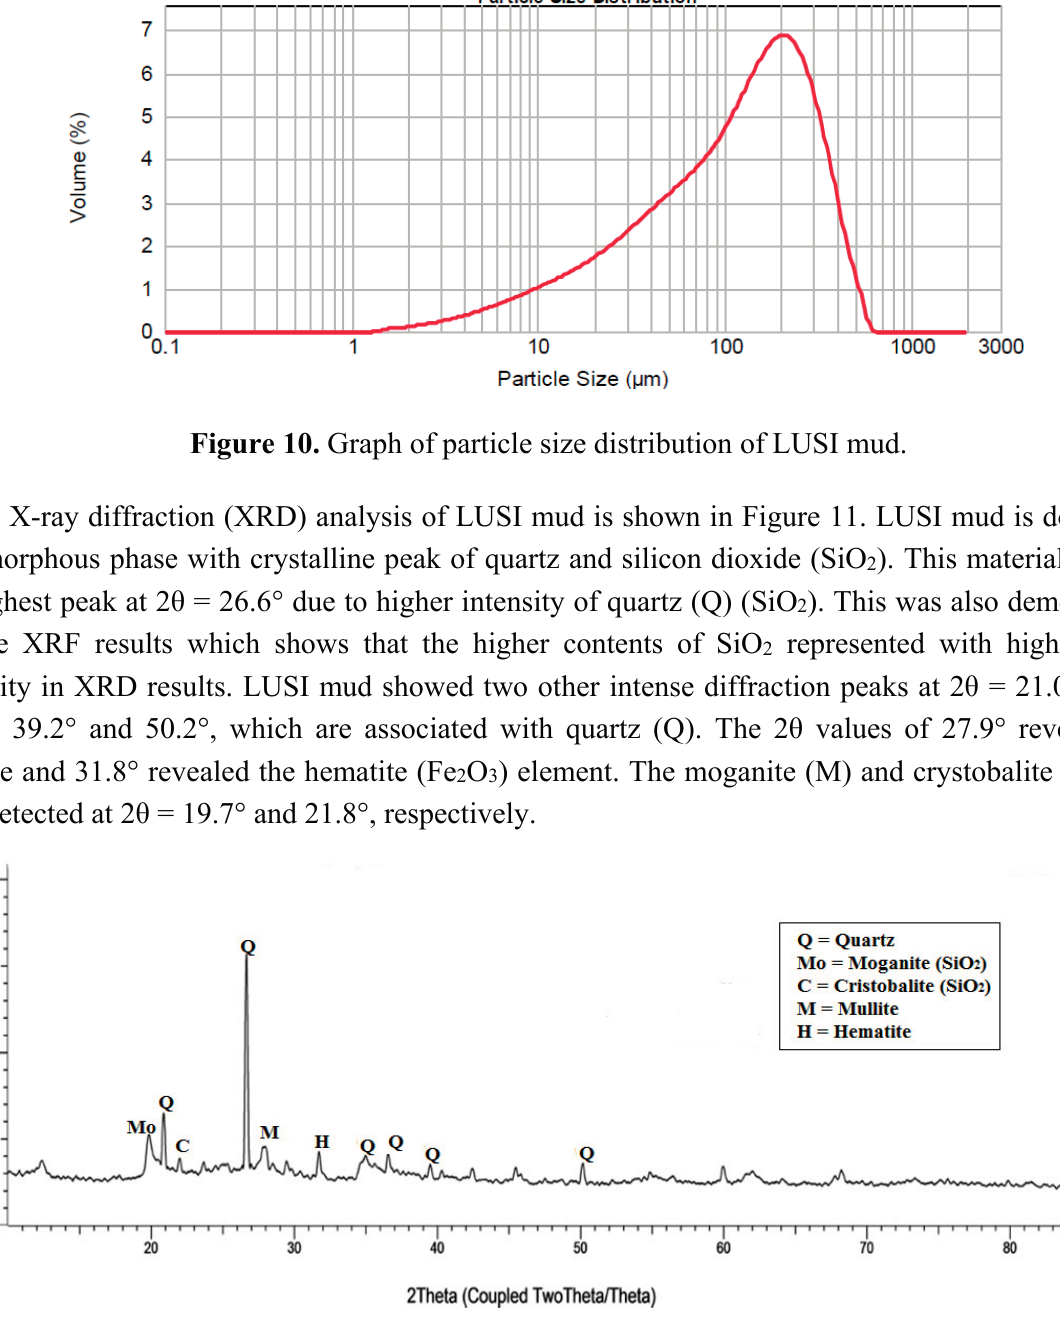
Figure 11. X-ray Diffractogram of original LUSI